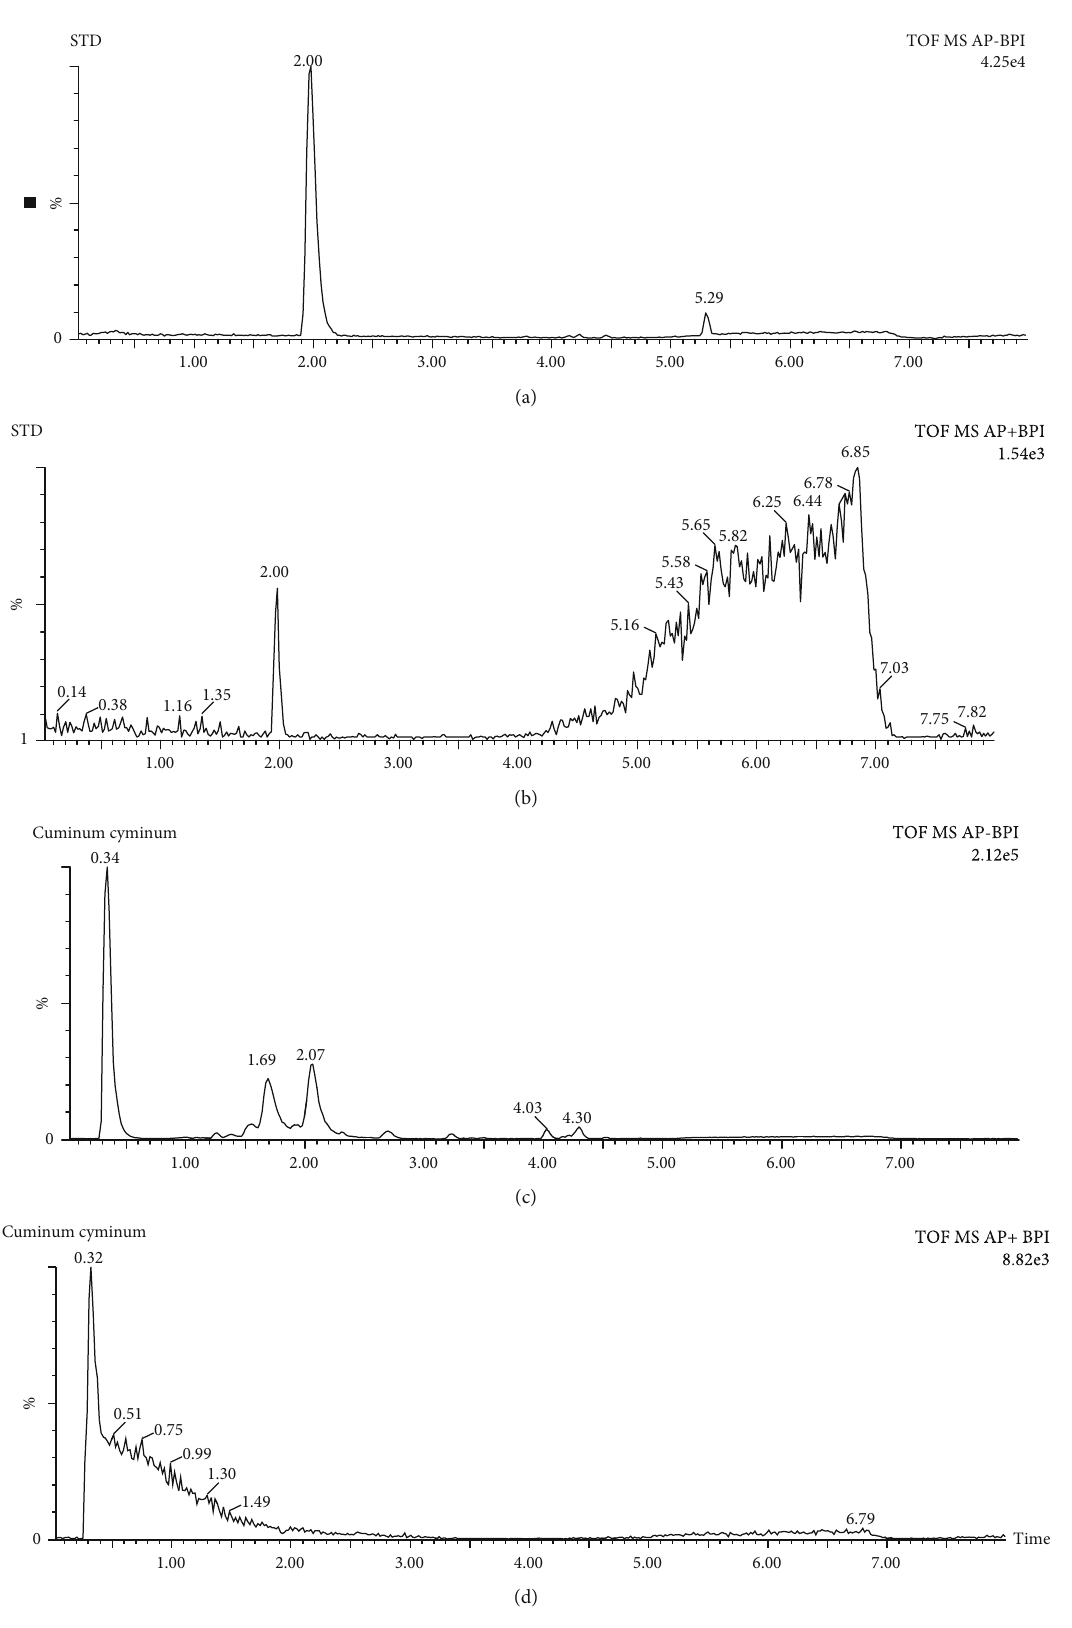
Figure 1: UPLC chromatogram of standard genistein and sample Cuminum cyminum ionized in negative mode (a, c) and in positive mode (b, d) by UPLC-APCI-TOF-MS,